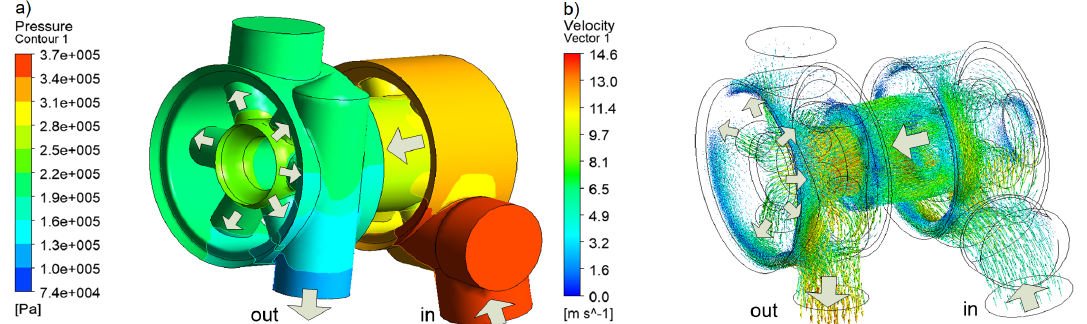
Figure 13. Simulation results obtained for a single seat valve at a flow rate Q = 10 dm 3 min − 1 : ( a ) pressure distribution, ( b ) velocity